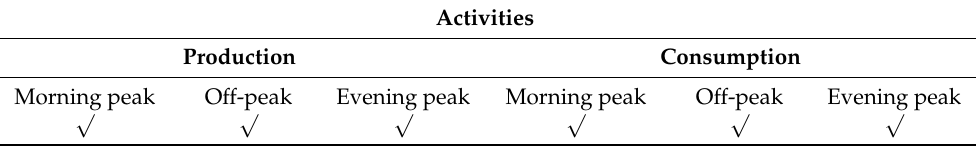
Table 3. Time of the day